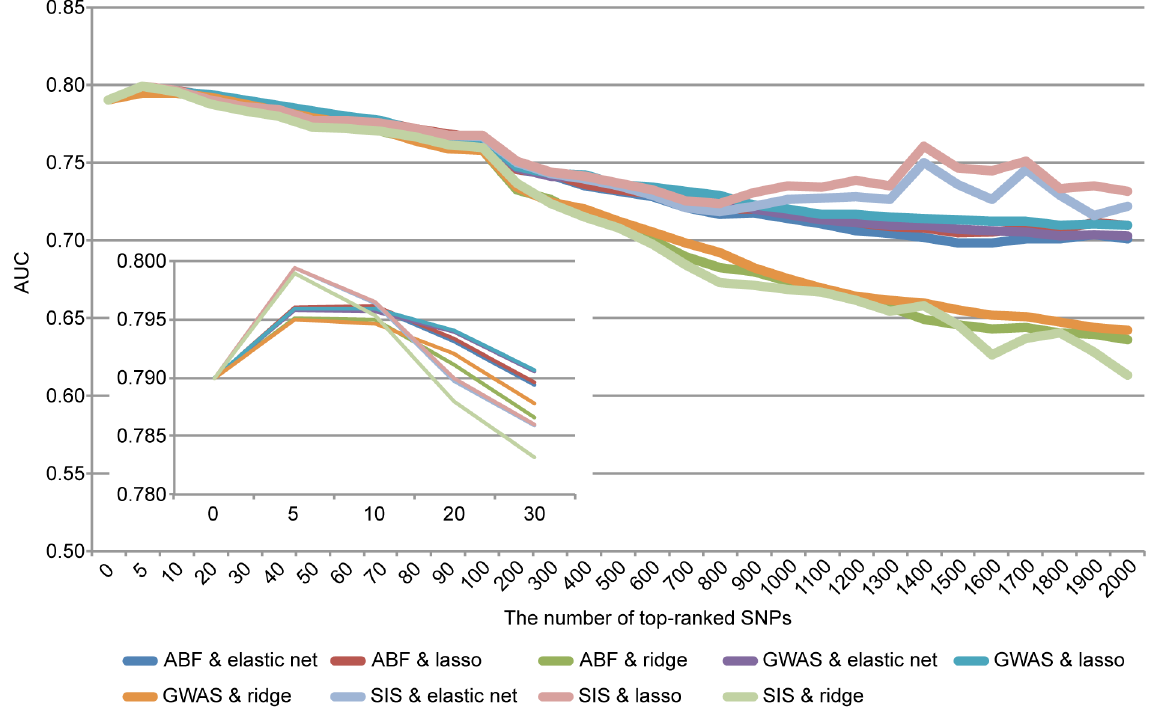
Figure 3. Risk prediction models using 10-fold cross-validation on the training set.